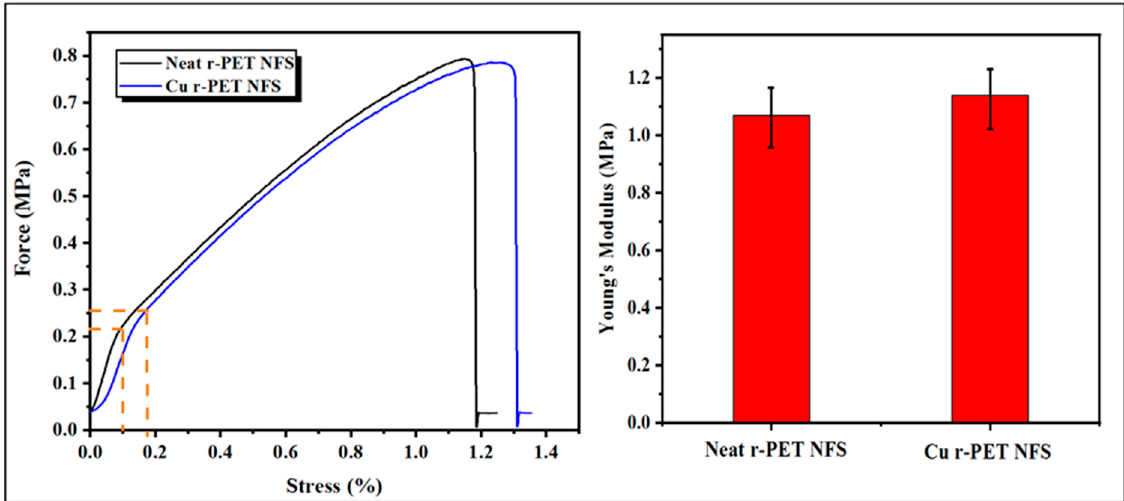
Figure 8. Stress–strain curve and Young’s modulus values of neat r-PET nanofibers and copper-coated r-PET nanofibers after the ELD process.